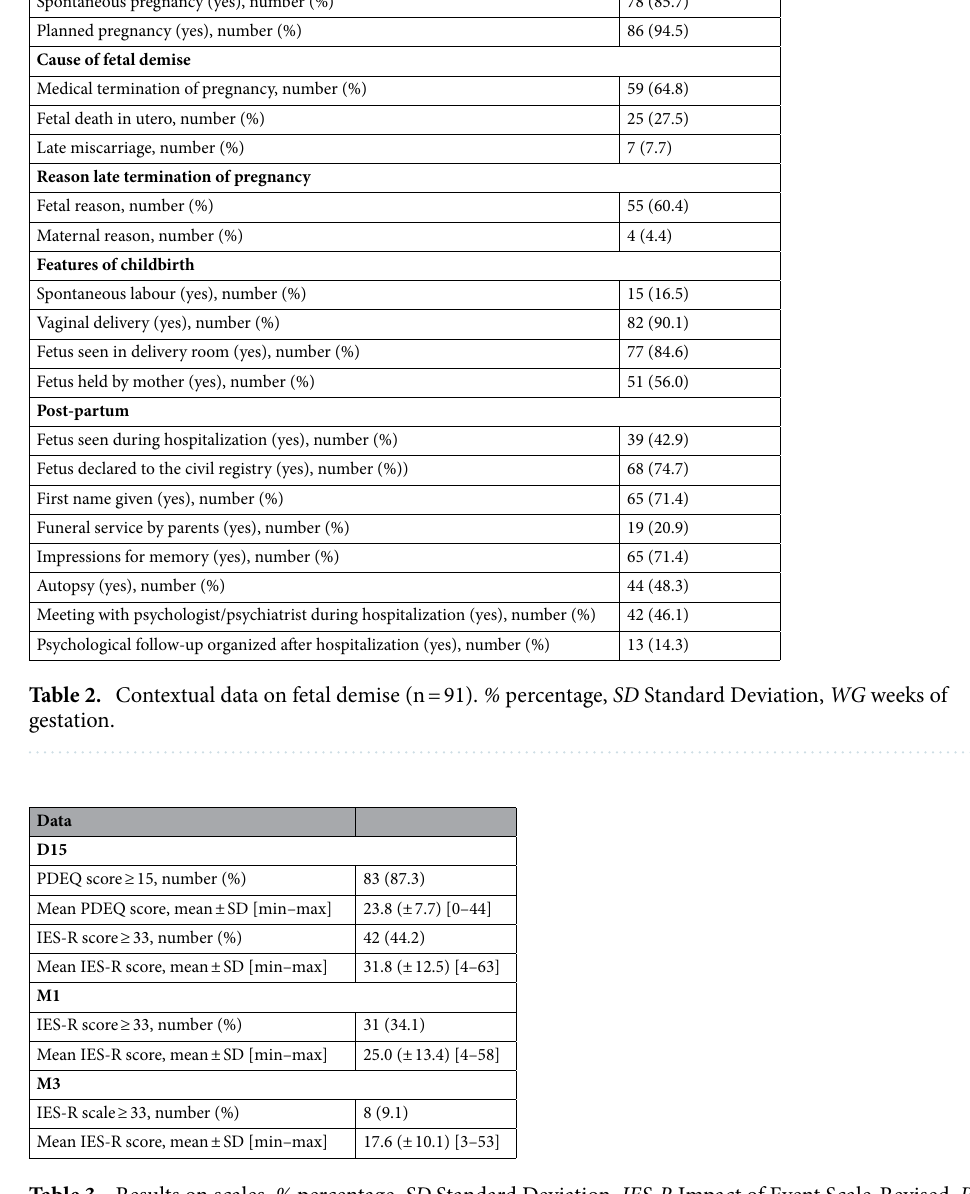
Table 3. Results on scales. % percentage, SD Standard Deviation, IES-R Impact of Event Scale-Revised, PDEQ Peritraumatic Dissociative Experiences